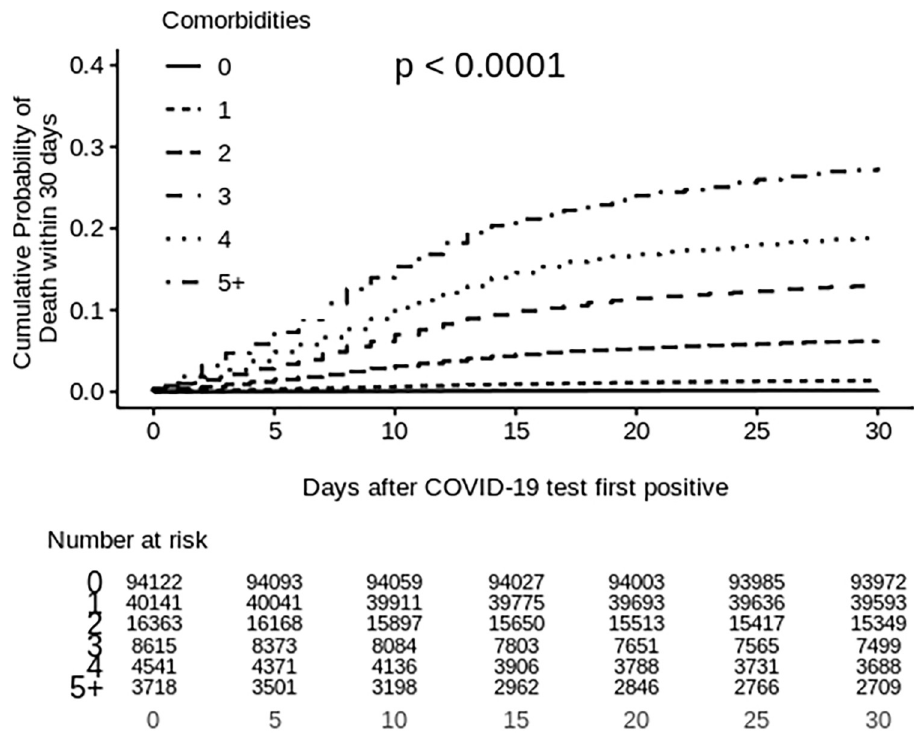
Fig 3. Cumulative probability of all-cause death within 30 days separated by number of